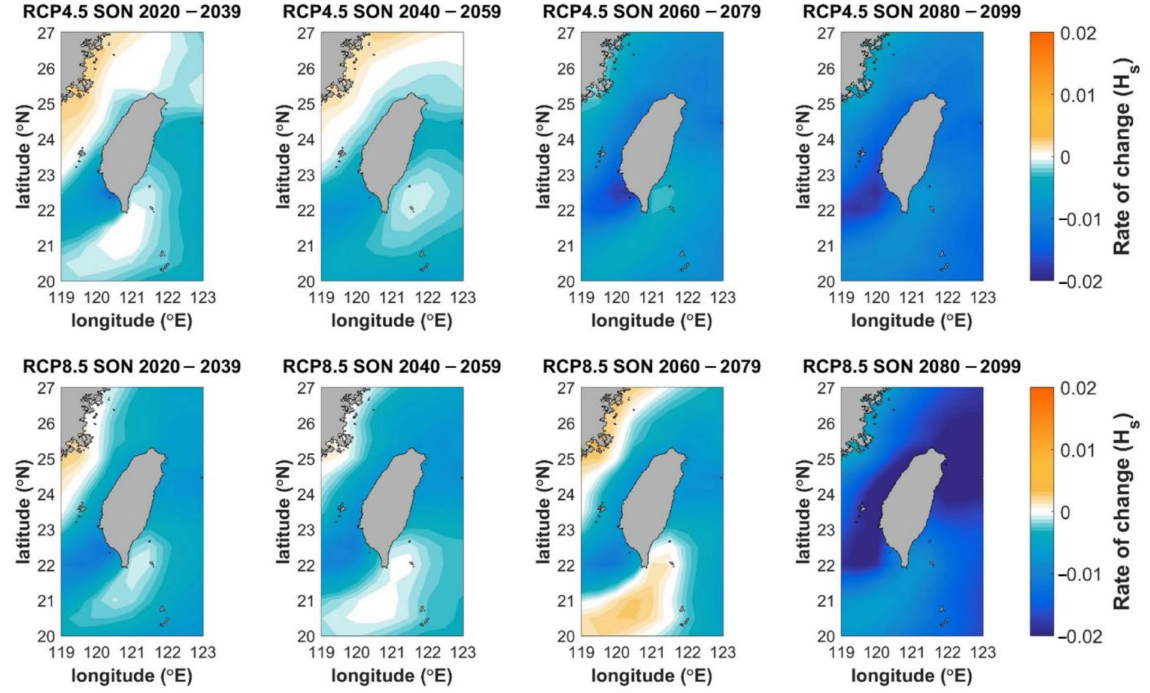
Figure 18. Rate of change in the seasonal mean of significant wave heights for each GCM, with respect to the reference period from 1980 to 2004 in the region of Taiwan in autumn for various